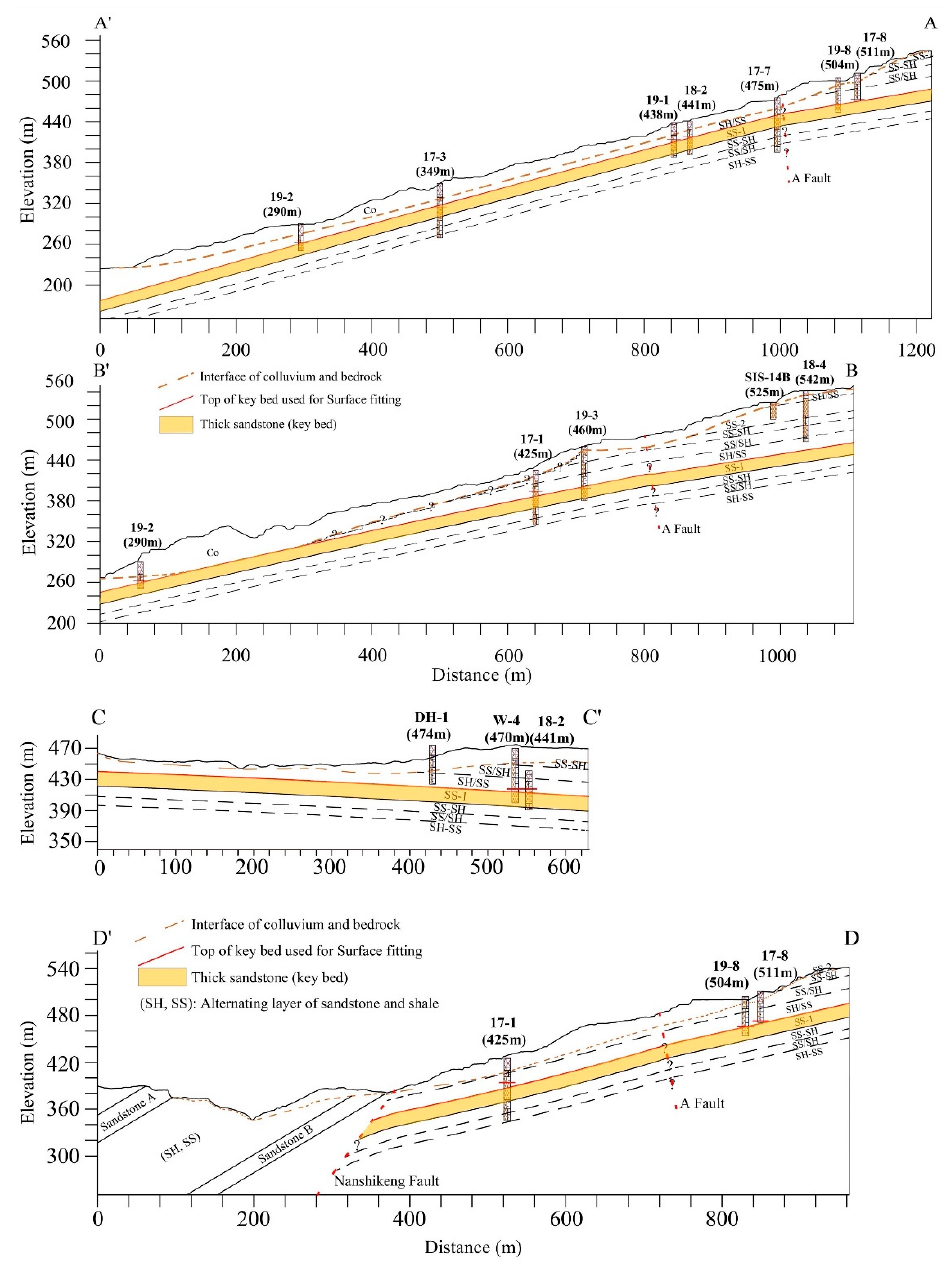
Figure 13. Geological cross-section profiles within the Mt. Dalun area. The colluvium boundary is plausibly compatible with the terrain (i.e., parallel to the topographical surface), and the deepest part of it does not cross over the thick sandstone layer (L4). The thickness of the colluvium is the largest in the lower half of the slope, and becomes increasingly thinner with topographical elevation. Two faults in the region contribute to the alteration of the spatial distribution of geological strata.